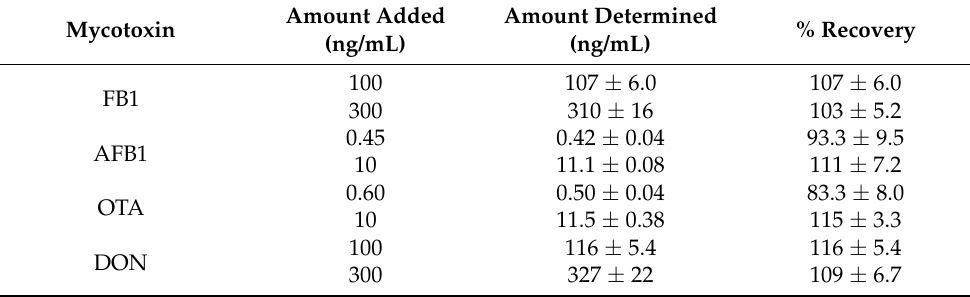
Table 2. Recovery of exogenous added mycotoxins in corn